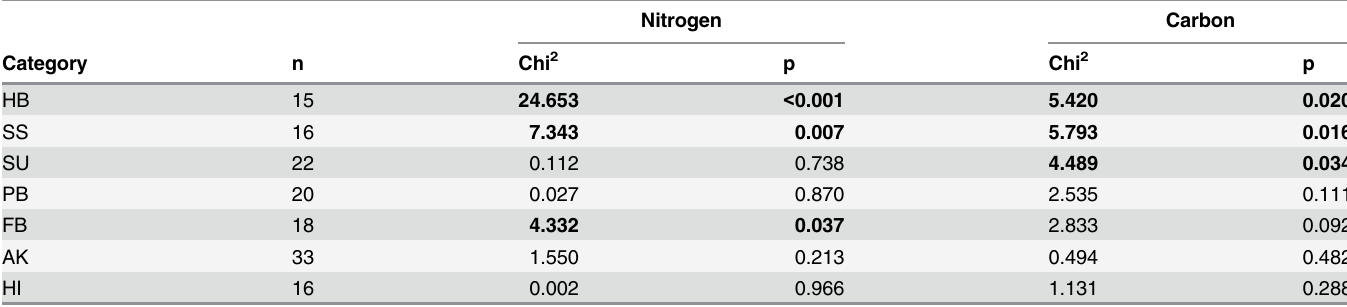
Table 3. Comparisons of variance between the breeding (April-May) and non-breeding (July – September) seasons, using Bartlett's chi-square test of variance equality. Nitrogen Carbon Category n Chi 2 p Chi 2